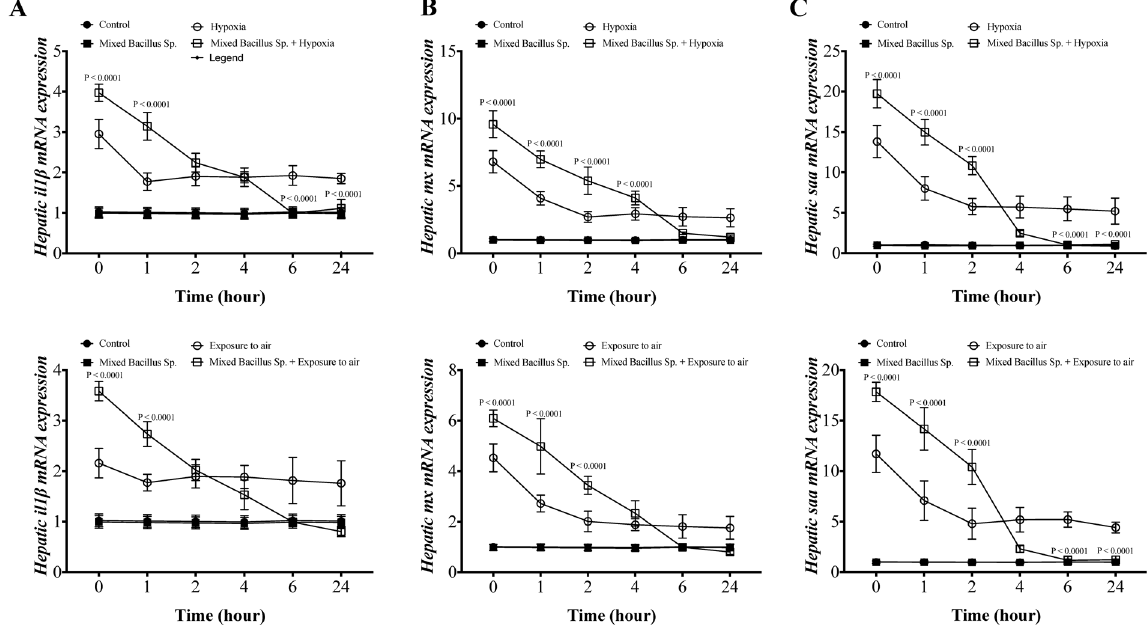
Figure 2. A mixed Bacillus Species induces hepatic gene expression of early innate immune mediators in Yellow perch response to experimental hypoxia and exposure to air stressors. Hepatic mRNA levels of ( A ) interleukin ( il1 β ), ( B ) mx transcript and ( C ) serum amyloid protein ( saa ) in Yellow Perch that subjected to ( A ) hypoxia and ( B ) air exposure stress over 24 h. Sample size = 9/group. Two-way Repeated measure ANOVA followed by comparing mixed Bacillus spp + stressed group to stressed groups was applied at two-tail significance level (P < 0.05). Data represented in mean ± SD.